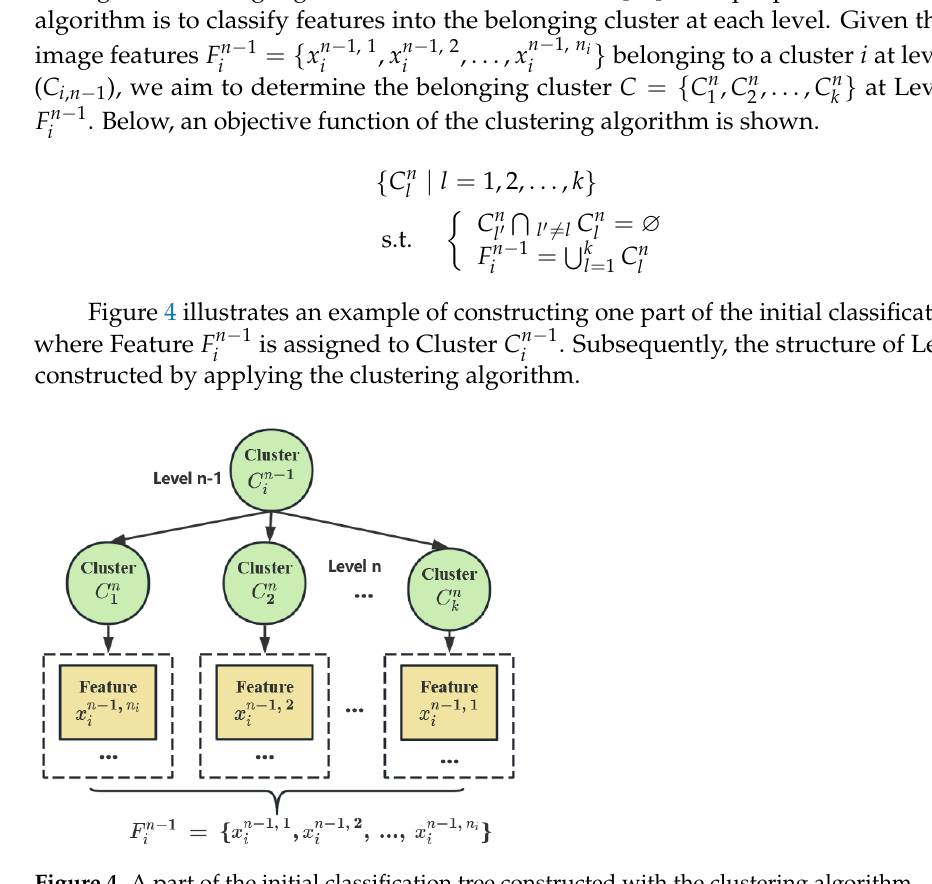
Figure 4. A part of the initial classification tree constructed with the clustering